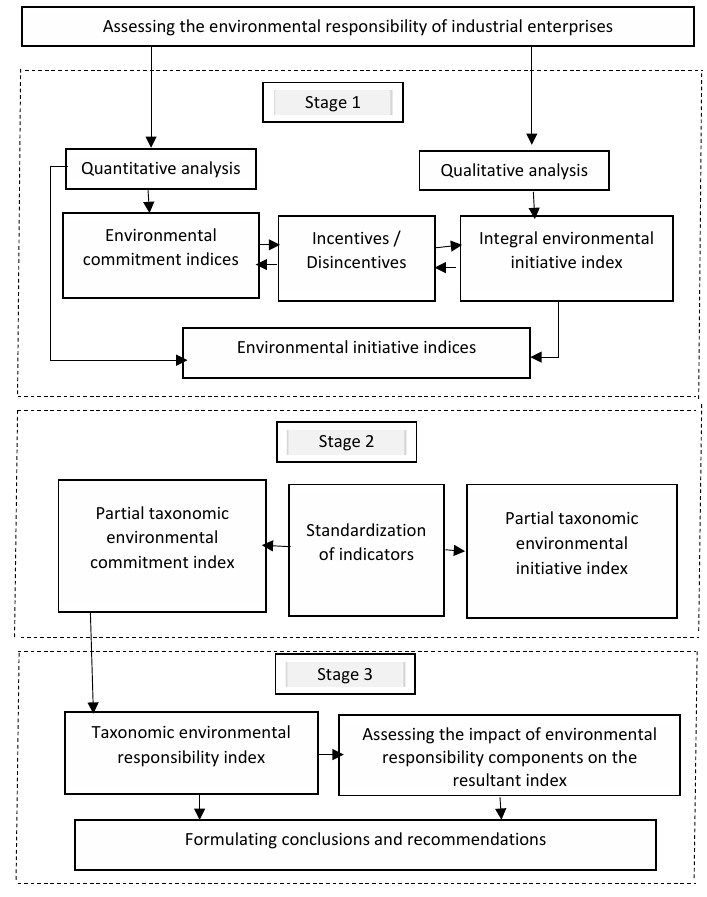
Fig. 2: Stages of assessing the environmental responsibility of industrial enterprises